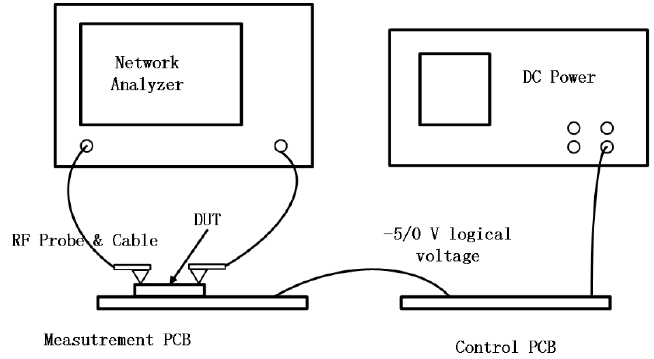
phase and attenuation errors in such a frequency bandwidth. Figure 6. The diagram of the measurement Figure 6. The diagram of the measurement setup.